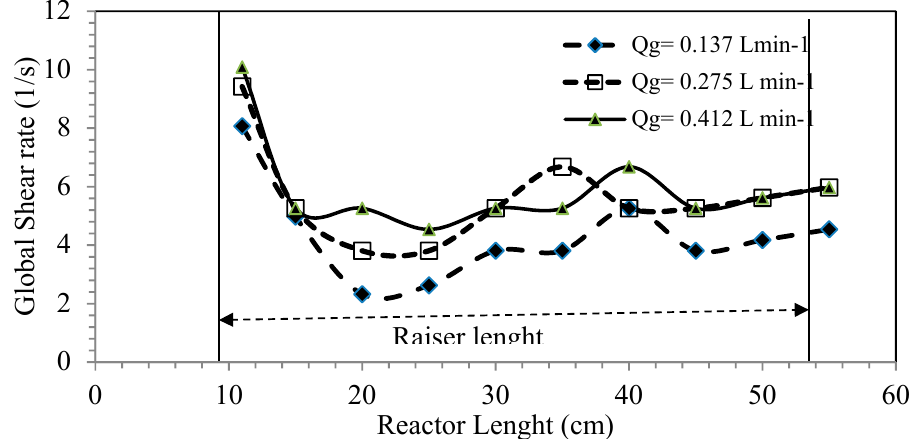
Figure 5. Global shear rate in the riser tube in function of the length of the reactor for the three gas flows studied.